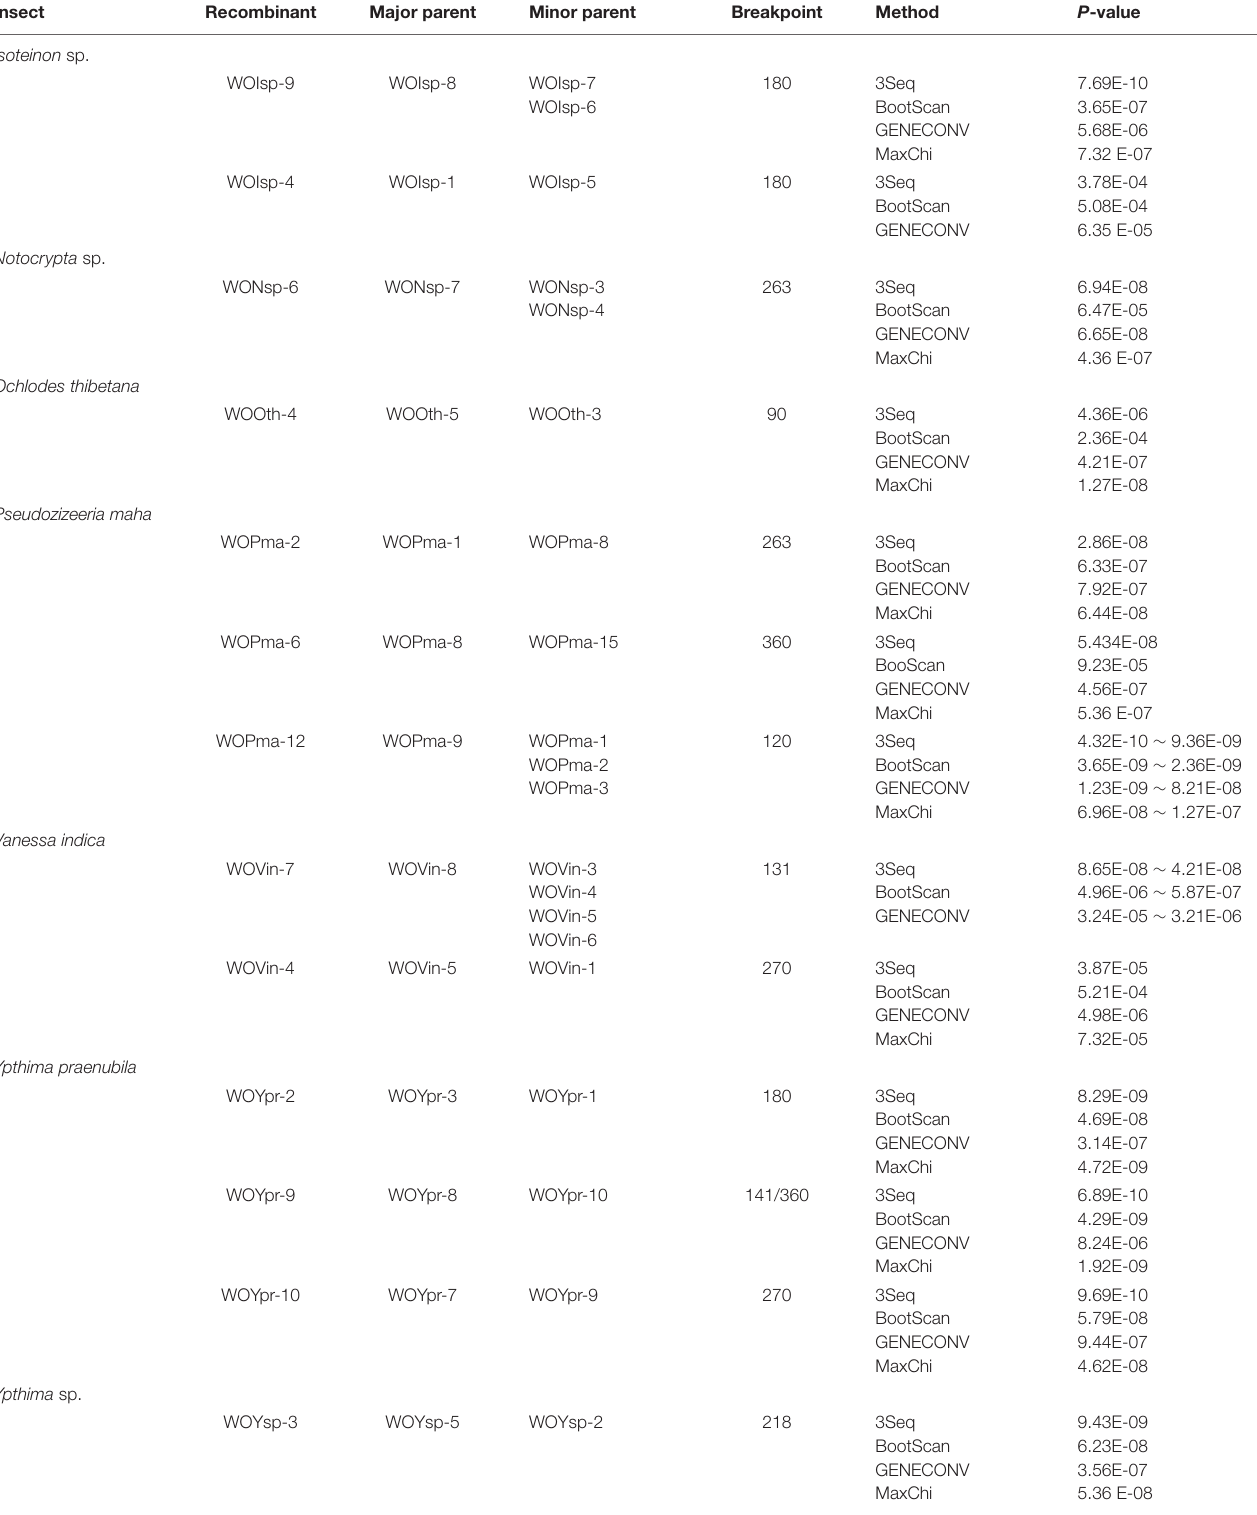
TABLE 2 | Recombination analysis of the phage WO orf7 gene in butterflies using six methods implemented in the RDP package. Insect Isoteinon